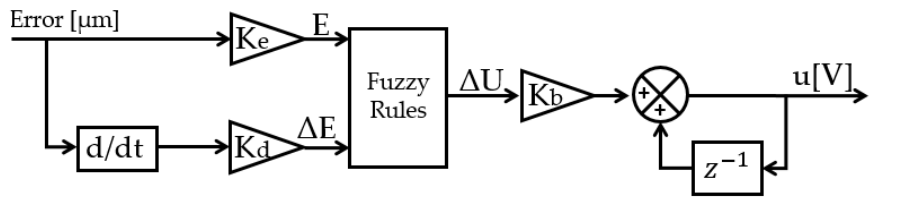
Figure 5. Type 1 fuzzy logic control